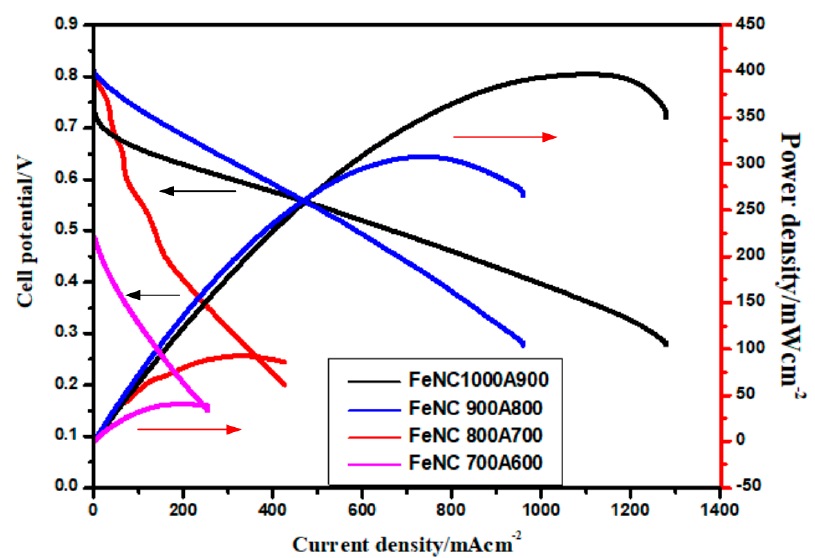
Figure 11. Power and current densities of single cells made of various FeNC cathode catalysts prepared with different calcination methods.